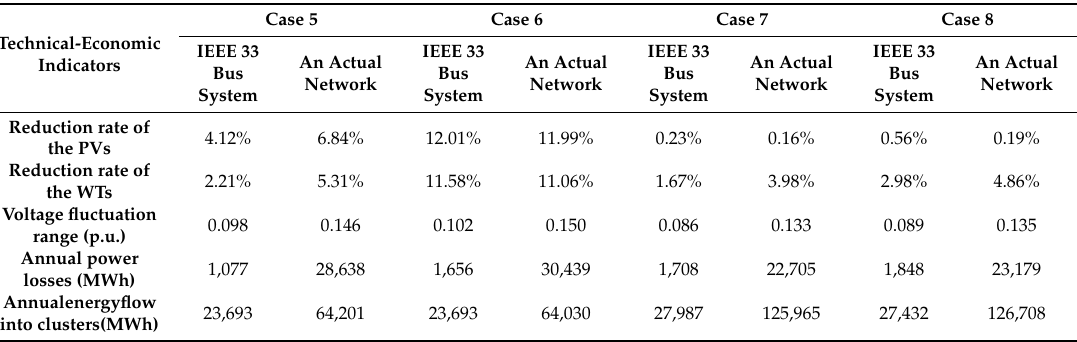
Table 7. Overall reduction rates in di ff erent